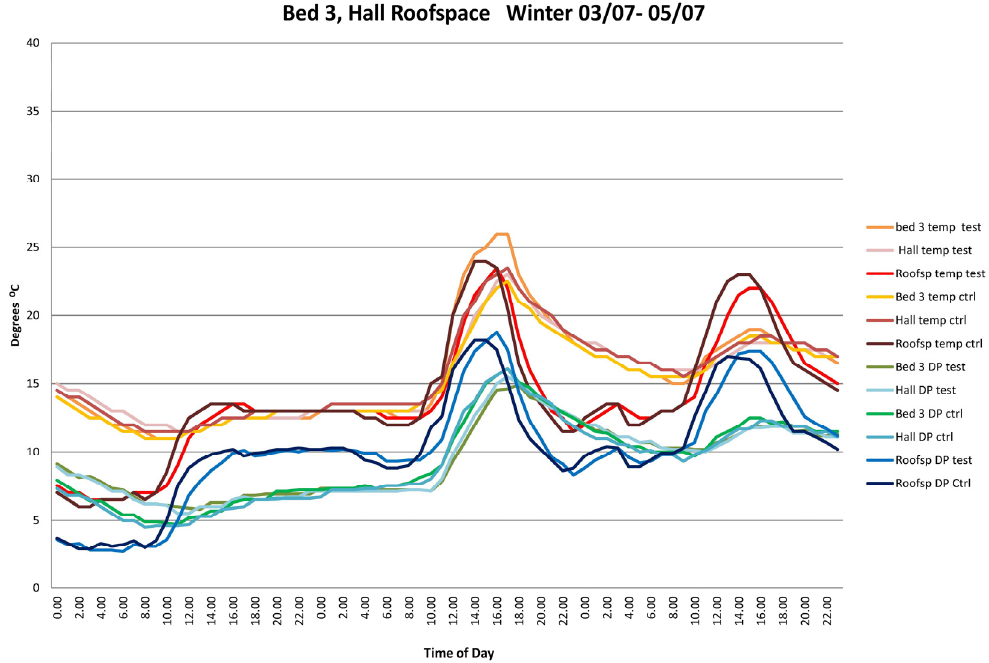
Figure 13. Dry bulb temperatures and dew point comparisons for the bedroom 3 hall and roofspace with external winter